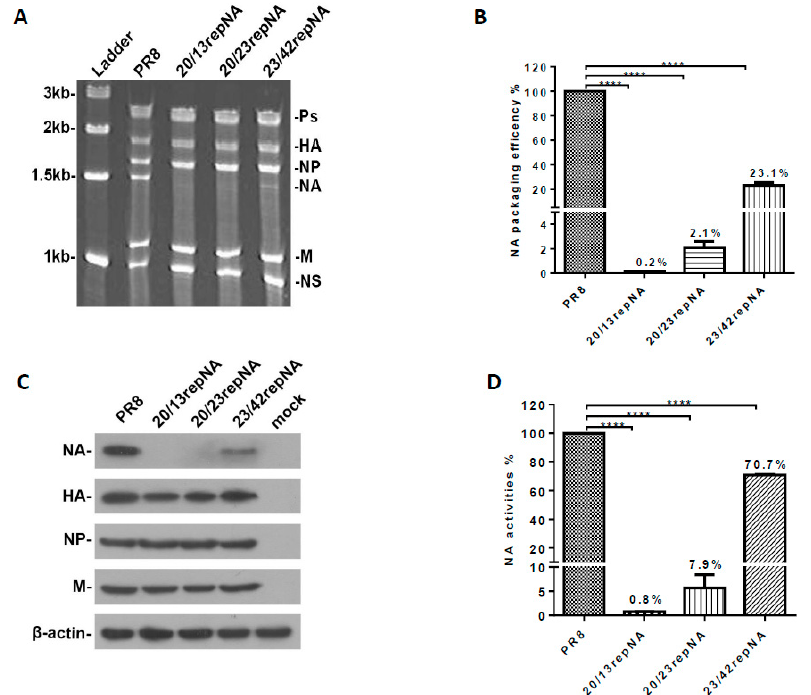
Figure 2. Analysis of the virion packaging efficiency and expression of the codon-reprogrammed NA gene. ( A ) Polyacrylamide gel electrophoresis of viral RNA. vRNAs were extracted from the purified viruses. One microgram of purified viral was loaded onto a 2.8% polyacrylamide gel containing 7.7 M urea and visualized following staining with SYBR Green II. The RNA segment that encodes the polymerase proteins (Ps), hemagglutinin (HA), nucleoprotein (NP), neuraminidase (NA), matrix (M), nonstructural protein (NS), and molecular weight of the ladders are indicated. ( B ) The packaging efficiency of the NA vRNA segment was determined by real-time quantitative PCR. The results are presented as the percentage of incorporated repNA vRNA relative to that of the wild-type PR8 virus. The average values of repNA packaging efficiency from three independent experiments are indicated in the columns. Bars denote standard deviations (SD). ( C ) Western blot analyses of viral protein expression in repNA viruses or wild-type PR8-infected (2 moi) MDCK cells at 12 h post infection. ( D ) The NA activity determination of repNA viruses by NA-specific substrate MUNANA. The average values of NA activity of repNA virus relative to that of wild-type PR8 virus from three independent assays are indicated on the columns. Bars denote SD. **** p < 0.0001 (Unpaired two-tailed Student’s t -test).